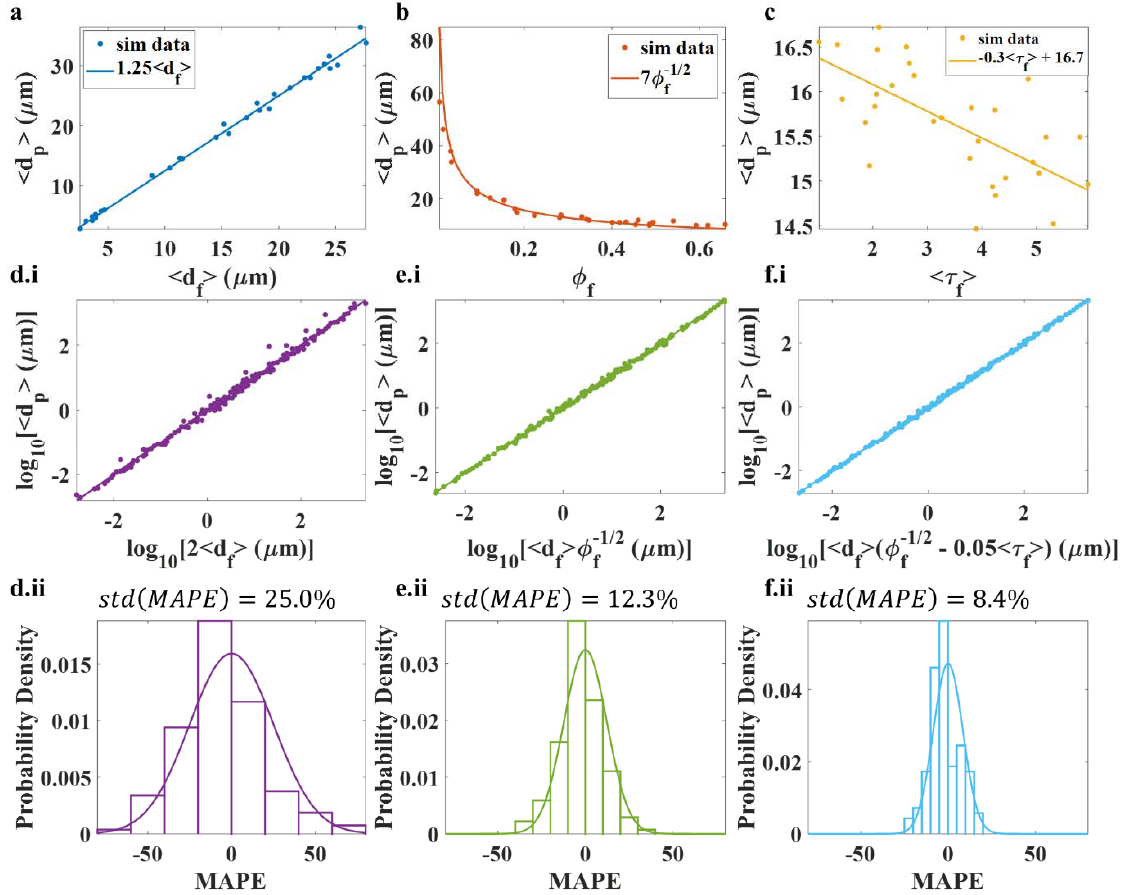
Figure 5. Characterization of mean pore size vs. FM model structure: ( a – c ) Univariate analysis of mean pore diameter vs. mean fiber diameter, fiber volume fraction, and mean fiber tortuosity. ( d.i – e.ii ) Multivariate analyses of mean pore diameter. ( d.i , d.ii ) When all properties of the FM are variable, fiber diameter is still a strong predictor of mean pore size. ( e.i , e.ii ) Mean fiber diameter combined with volume fraction offers better predictive power than mean fiber diameter alone. ( f.i , f.ii ) Mean fiber tortuosity significantly increased the predictive power for this multivariate